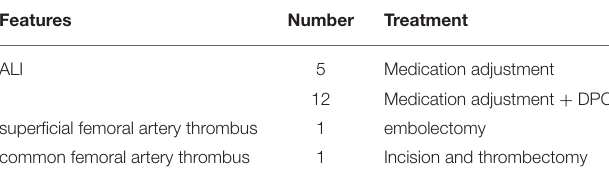
TABLE 3 | Limb ischemia patients clinical features.